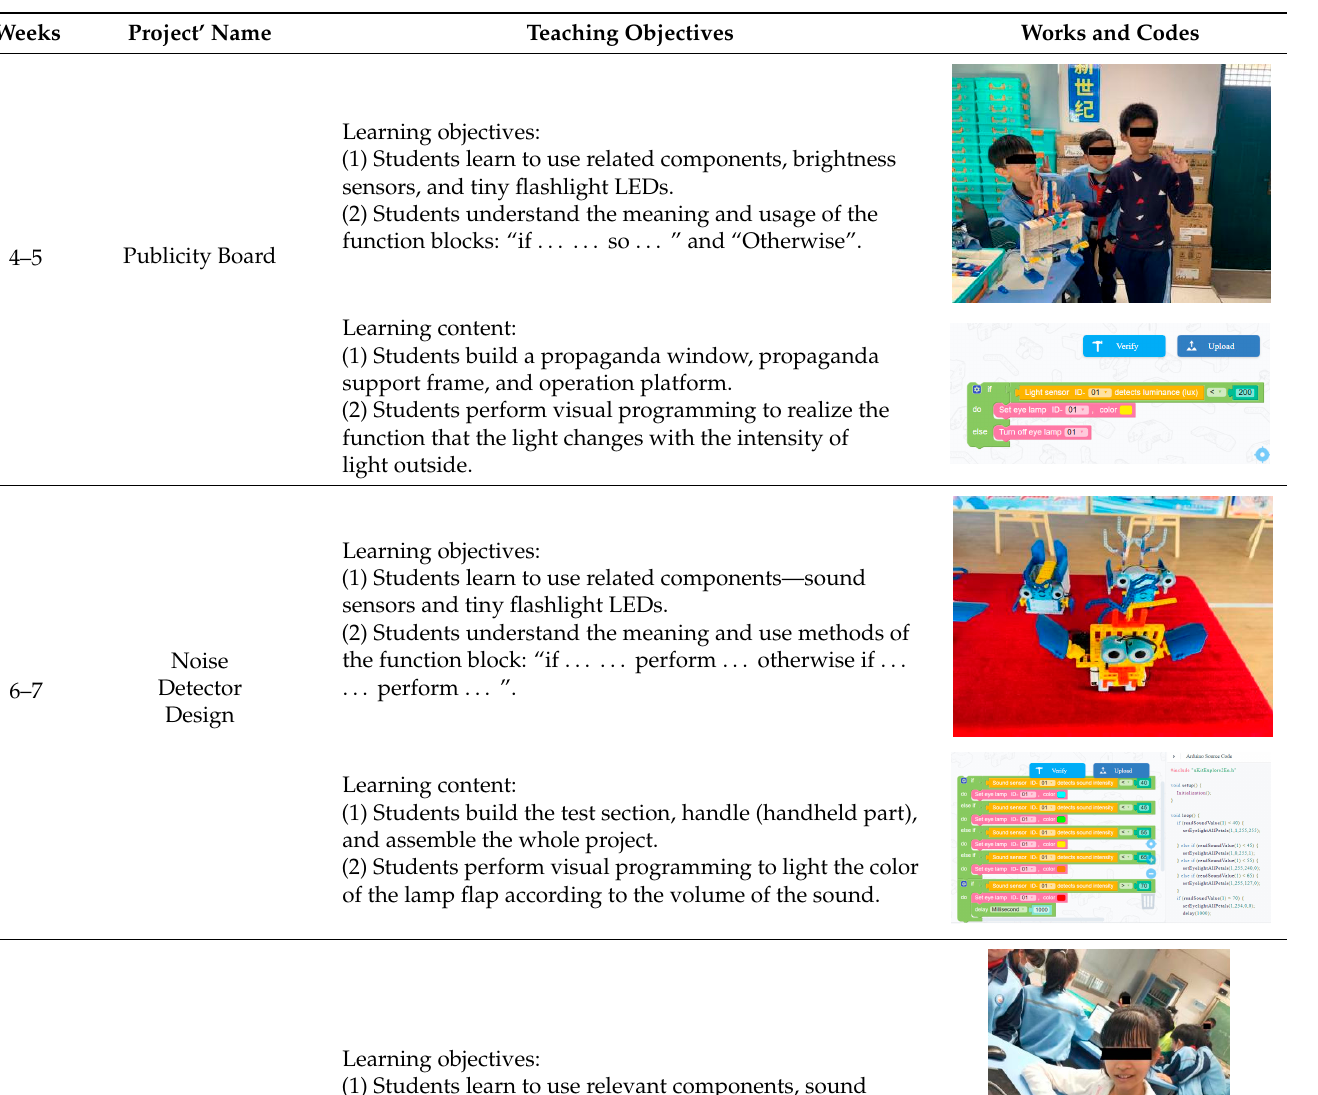
Table A1. Information on the control group’s six items.